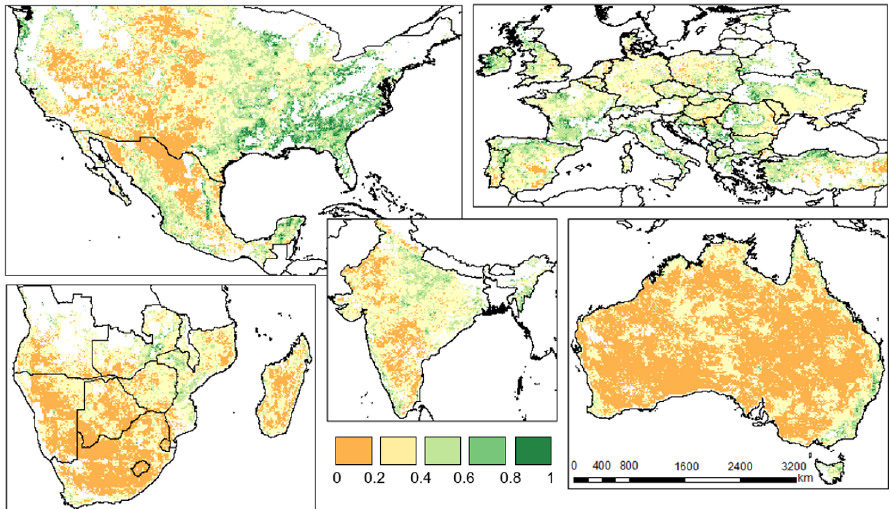
Figure 9. Maps representing the ensemble mean weighting factor for the LIS dataset according to the error maps derived from the TC